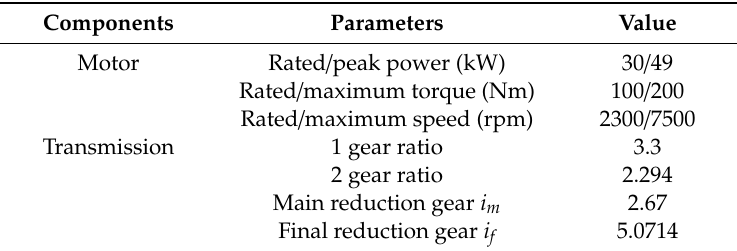
Table 2. Powertrain specifications of